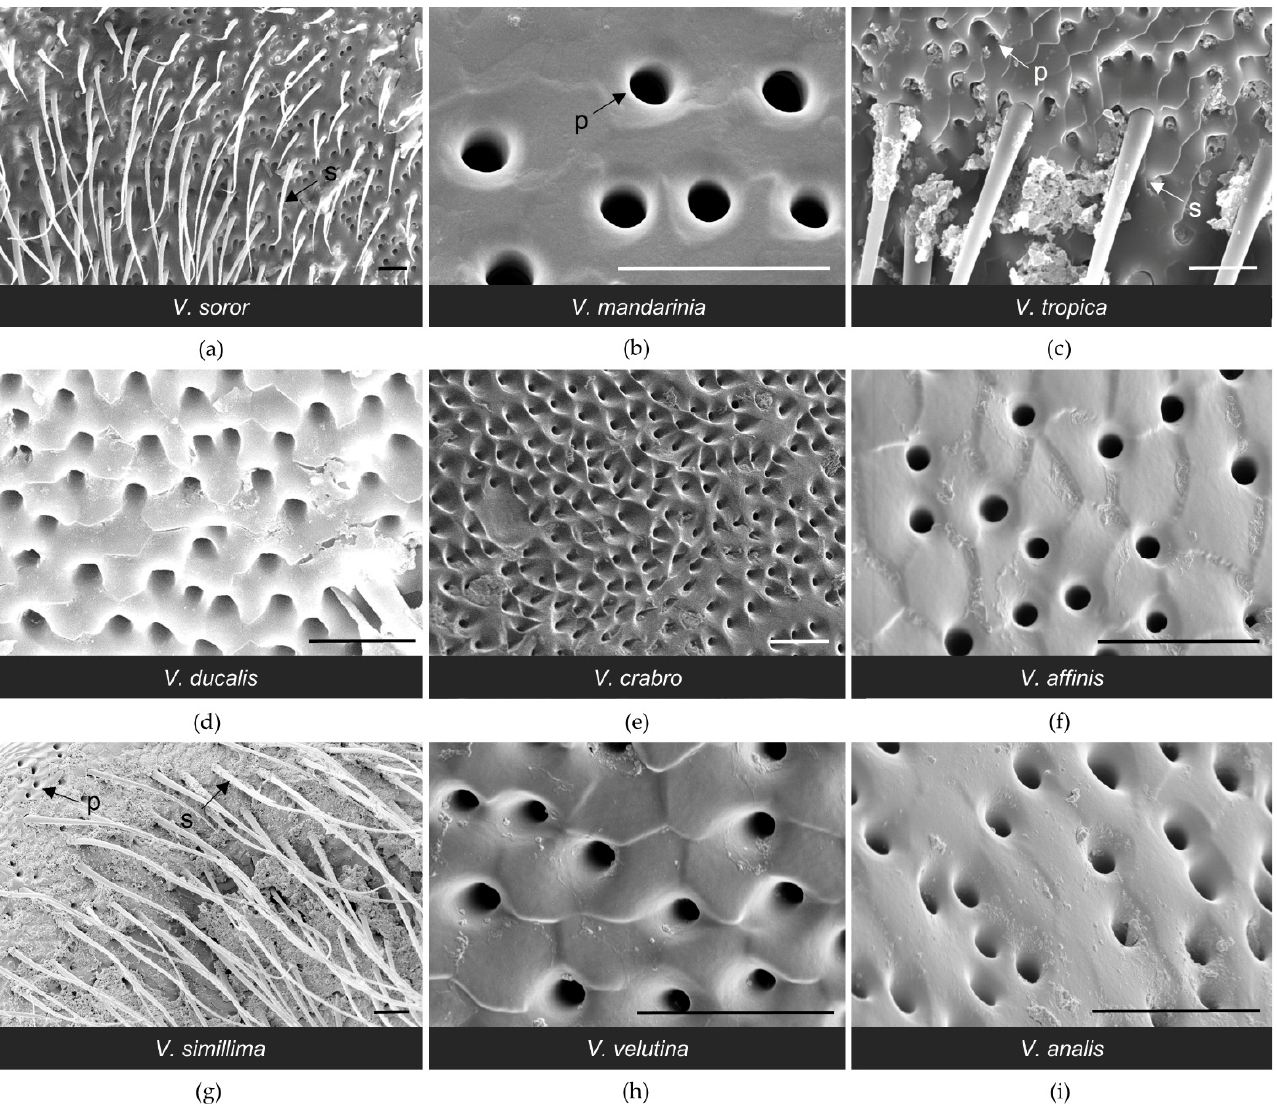
Figure 6. High magnification SEM images of the van der Vecht gland showing differences in cuti-cular texture across species. Anterior is at the top. Species are presented in the order in which they appear in the phylogeny depicted in Figure 1. The region where pores overlap with setae at the margin of the sternal brush is shown in ( a , c , g ). Regions of pore clusters without setae are shown in ( b , d – f , h , i ). Bars indicate 20 μ m for scale; s = seta of sternal brush; p = pore opening.